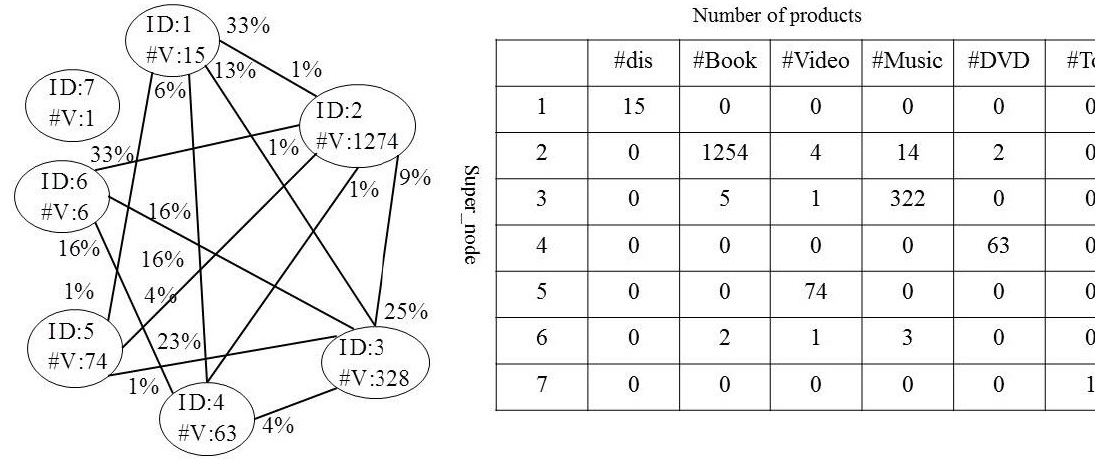
Figure 6: The second summary graph of the size of 7